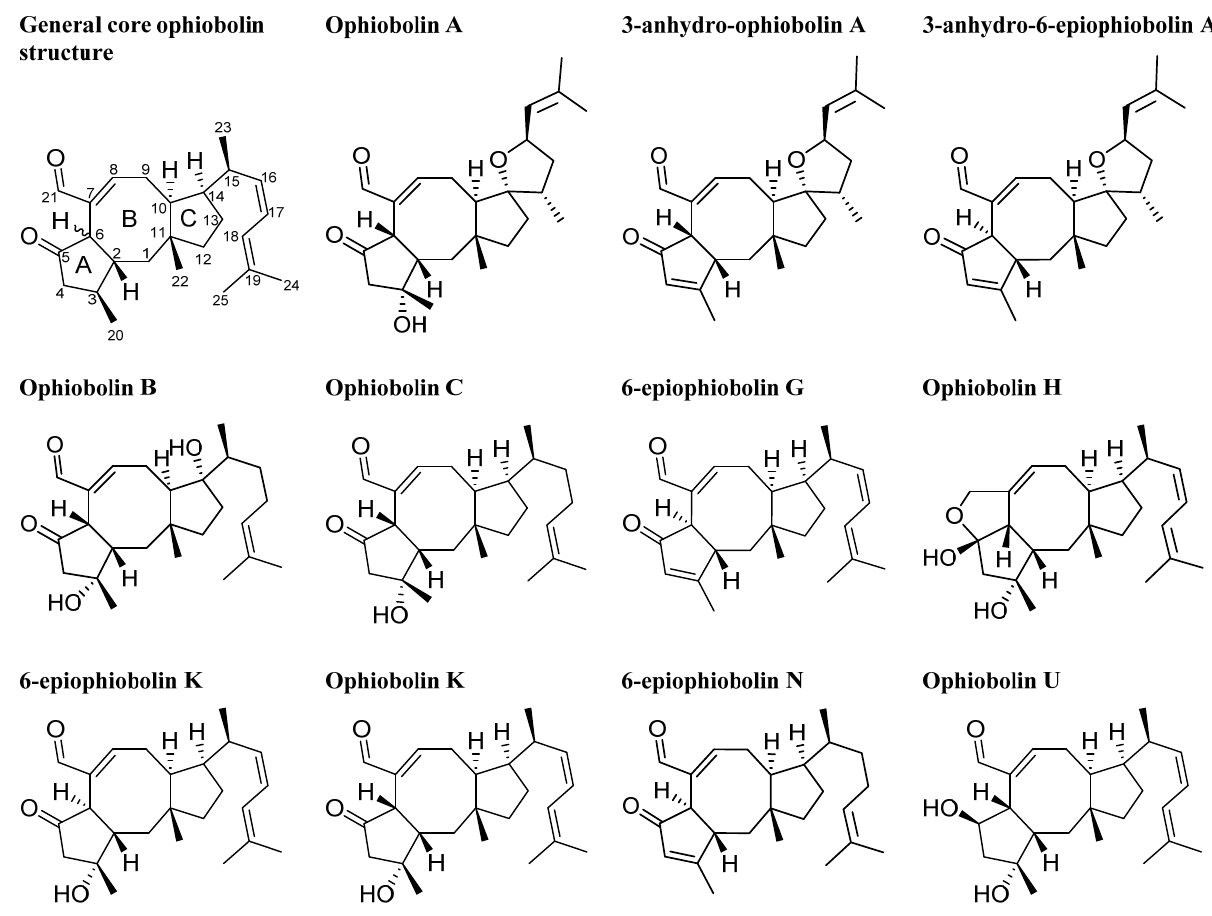
Figure 7. Structures of ophiobolin A, 3-anhydro-ophiobolin A, 3-anhydro-6-epiophiobolin A, ophiobolin B, ophiobolin C, 6-epiophiobolin G, ophiobolin H, 6-epiophiobolin K, ophiobolin K, 6-epiophiobolin N, and ophiobolin